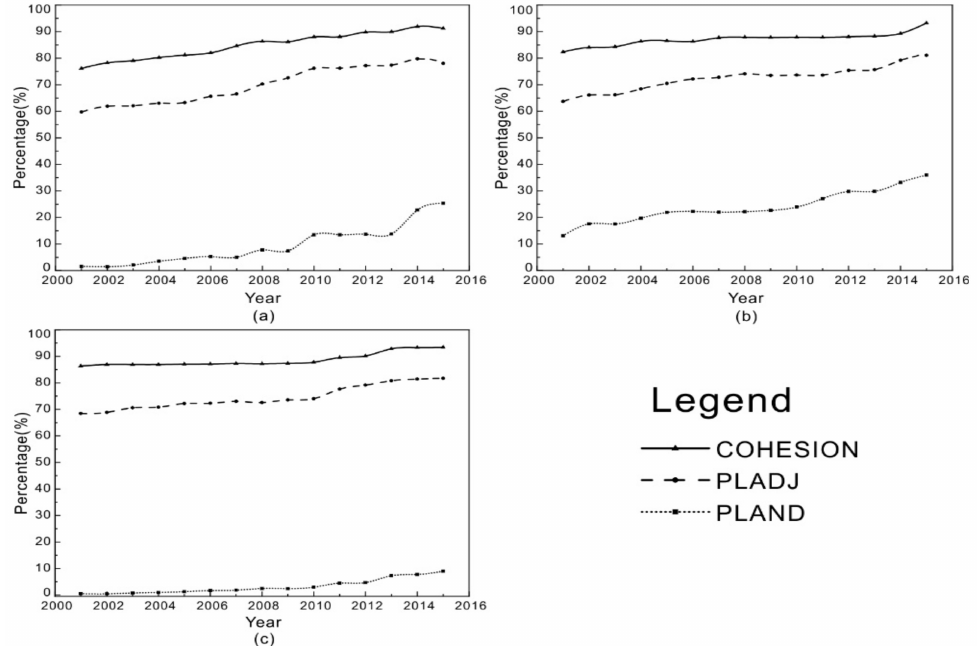
Figure 4. The dynamics of UHI patches: ( a ) strong heat islands; ( b ) moderate heat islands; and ( c ) weak heat islands.